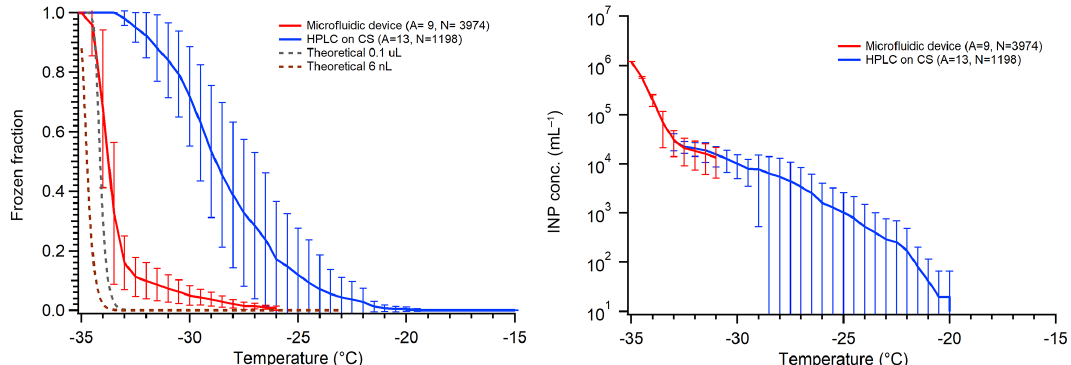
Figure 10. Comparison of pure water droplet freezing in our new microfluidic chip (red) versus using a silanized cover slip (CS) (blue), following Fig. 5. Droplets in the microfluidic chip are 6nL in volume and droplets on the CS are 0.1µL. Error bars show variability of droplet freezing between different replicate arrays. The parentheses next to each legend entry contains the number of arrays of droplets (A ) and the total number of droplets across all arrays ( N ). The gray and dark red dashed lines indicate the theoretical homogeneous freezing curves of 0.1µL and 6nL droplets, respectively, using the parameterization of Koop and Murray